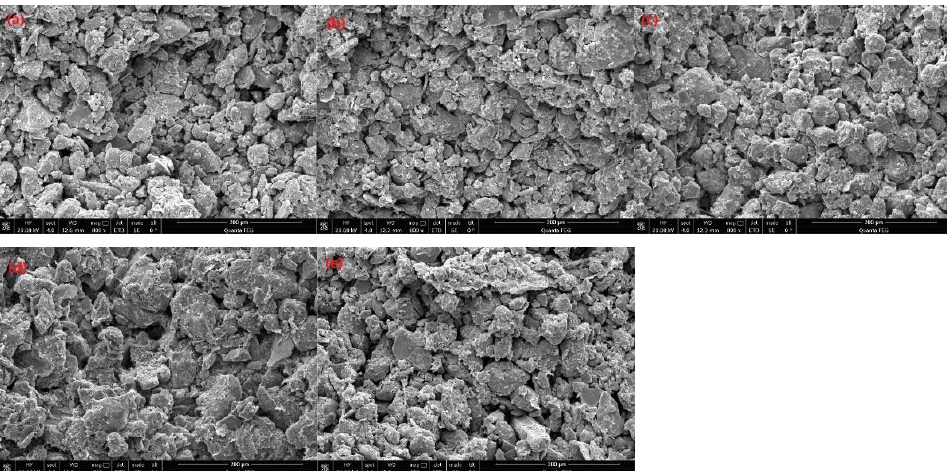
Figure 6. SEM photographs of intact loess specimens at different creep status: ( a ) before test; ( b ) decay creep; ( c ) steady creep; ( d ) before creep test; ( e ) after creep test.